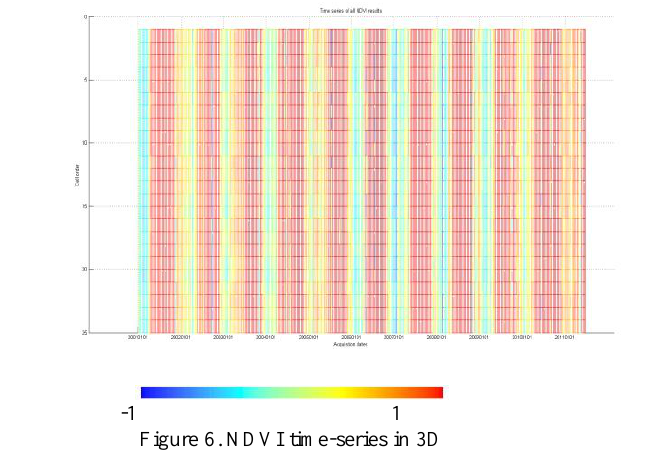
are for High and Low NDVI values respectively.